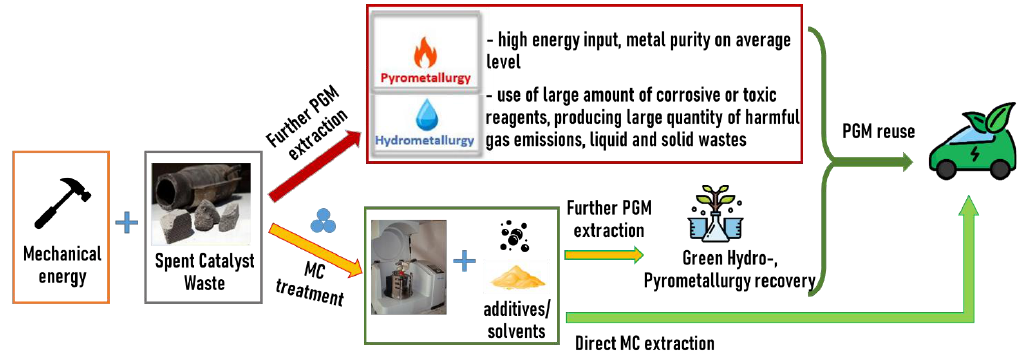
Figure 11. PGM recycling improvement by mechanochemical method.